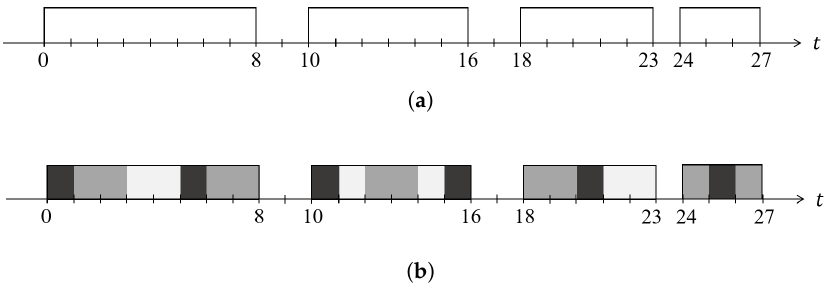
Figure 3. An example of the schedules produced from a task set of three tasks [48]. The ScheduLeak algorithm can recover the precise schedules from the observed busy intervals. ( a ) Busy intervals observed by attacker’s observer task. ( b ) Schedules reconstructed by the ScheduLeak